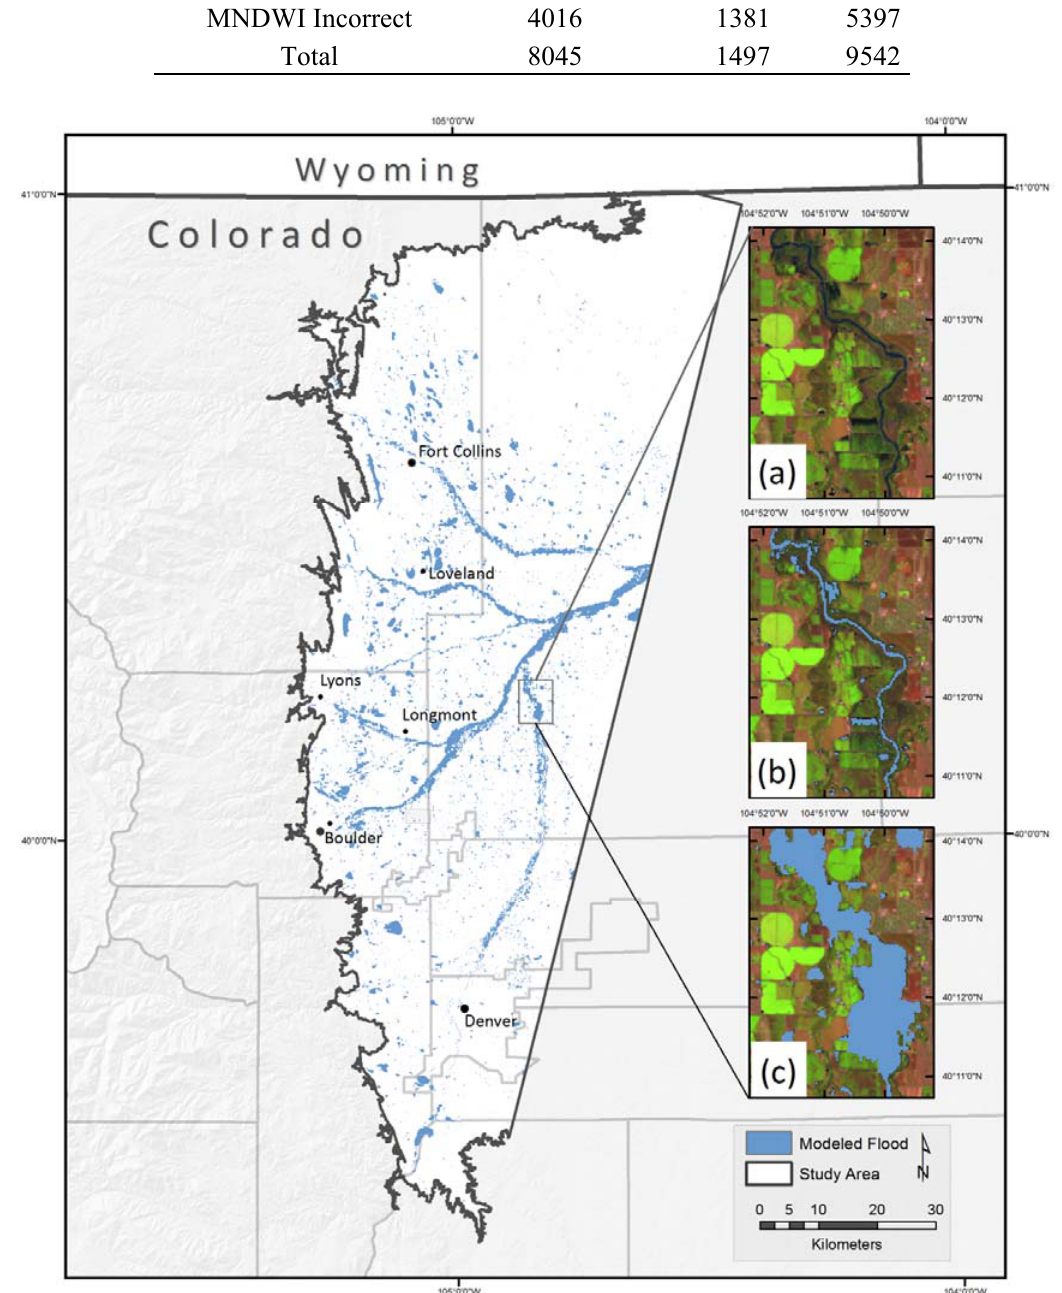
Figure 9. Study area showing the full extent of the ICA modeled flood. Insets show a reach of the South Platte River; ( a ) post-flood Landsat 8 image displayed in false color (SWIR1-NIR-R): water is dark blue, moist soil is dark brown, vegetation is green, and bare ground is red-orange; ( b ) modeled flood extent derived from MNDWI threshold of the post-flood image: the swollen channel and other surface water is displayed in blue ( c ) ICA modeled flood at the same location, showing inundation of the floodplain and agreement with the dark moisture patterns visible in